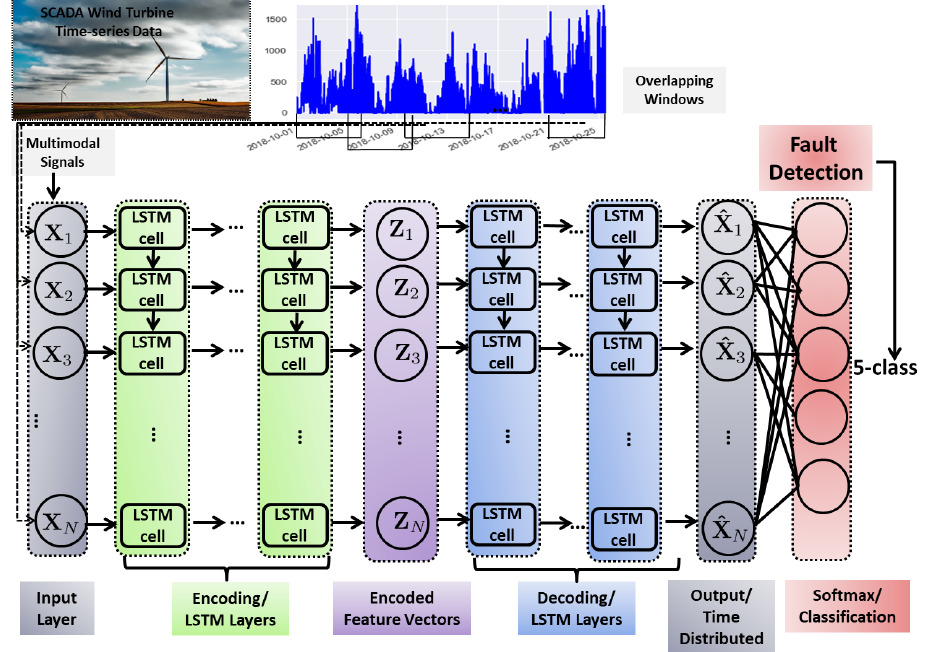
Figure 1. Long Short Term Memory-Stacked Autoencoders (LSTM-SAE) Architecture: This scenario exploits a Stacked Sparse Autocoders scheme, with LSTM hidden layers that consider the recursive structure of the investigated time-series. The final layer of the LSTM-SAE scheme is a fully-connected, time distributed layer, while the Classification layer is a fully-connected one, activated with the Softmax function, containing the corresponding classes for each